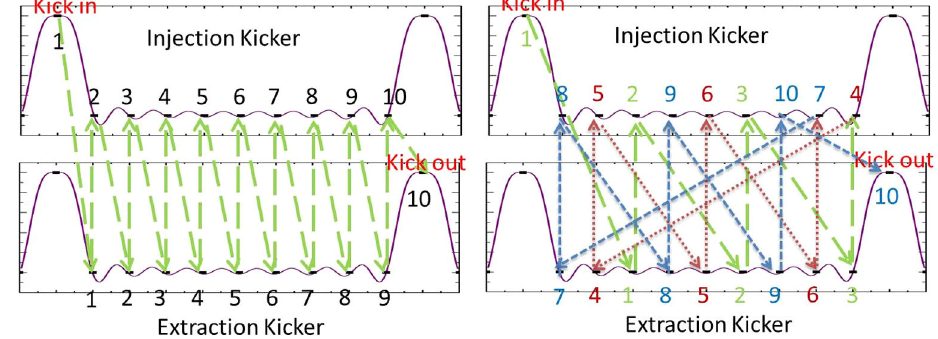
FIG. 6. Kicker scheme for 10-turn recirculation with two identical kickers, the alternating bunch kick is in one bunch spacing (left) and three bunch spacing (right).